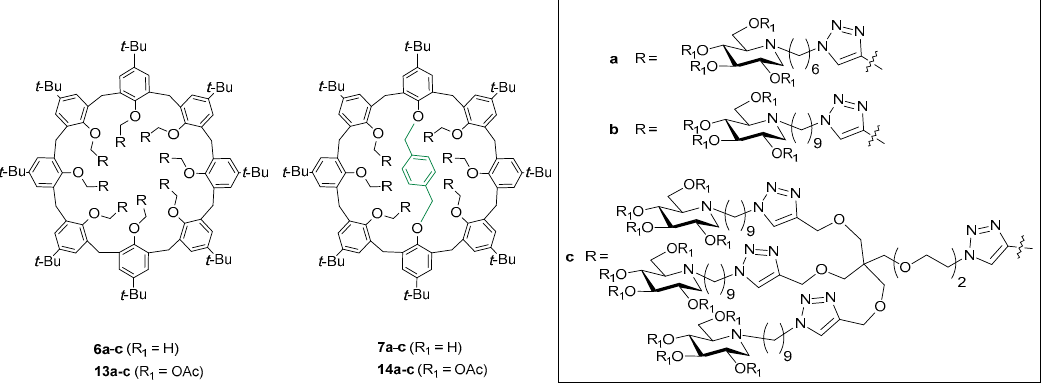
Figure 2. Calix[8]arene based multivalent clusters 6a – c and 7a – c . For a full picture of those compounds see SI Figures S1–S6.